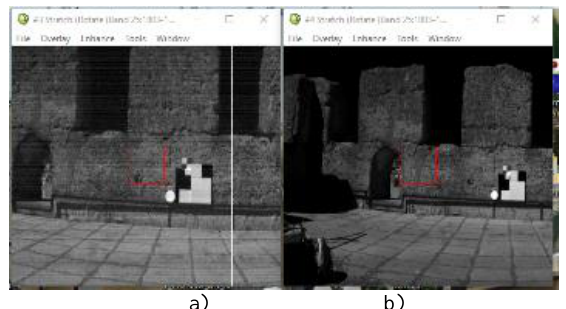
Figure 8. Normalization with respect to spectralon and polycarbonate to a) 3 m, b) 4 m